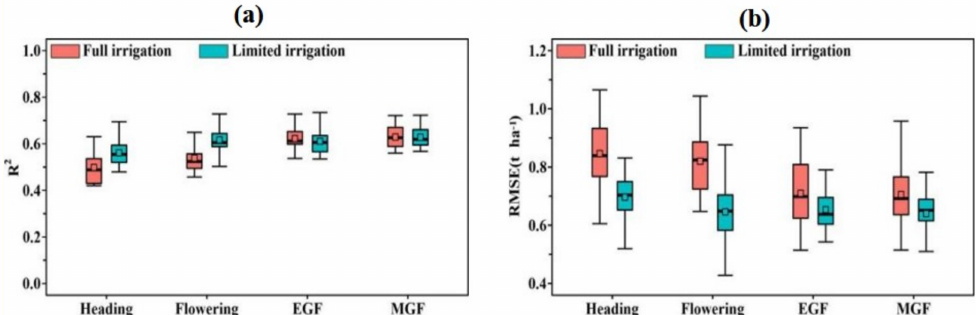
Figure 9. The statistical distributions of prediction accuracy of the stacking regression when including four base learners for predicting grain yield in the test phases; ( a ) distributions of R 2 at the heading stage; ( b ) distributions of RMSE at heading; EGF, early grain filling and MGF, mid-grain filling. In terms of the mean R 2 and RMSE, most of the ensemble models achieved higher prediction accuracy than the individual best models (Table 5), which confirmed the effec- tiveness of the ensemble model implemented in this study. In addition, the overall accuracy indicated that the prediction performance of the ensemble model was proportional to the number of base learners (Figure 10).